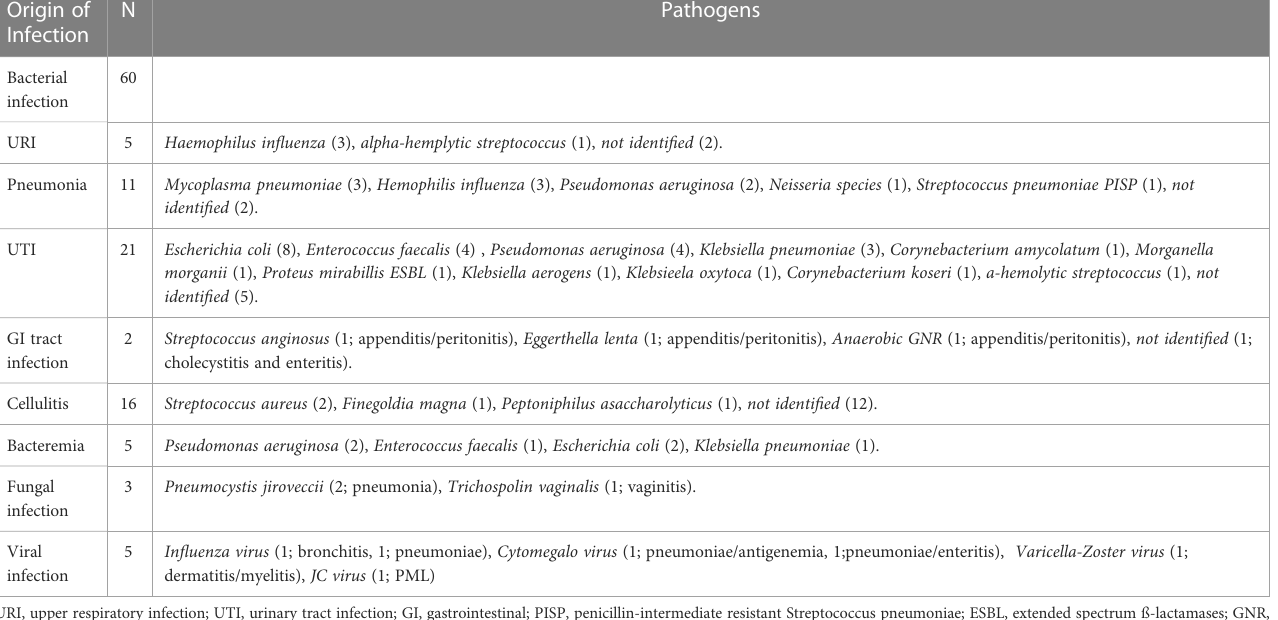
TABLE 1 Origins of infection and pathogens. Origin of